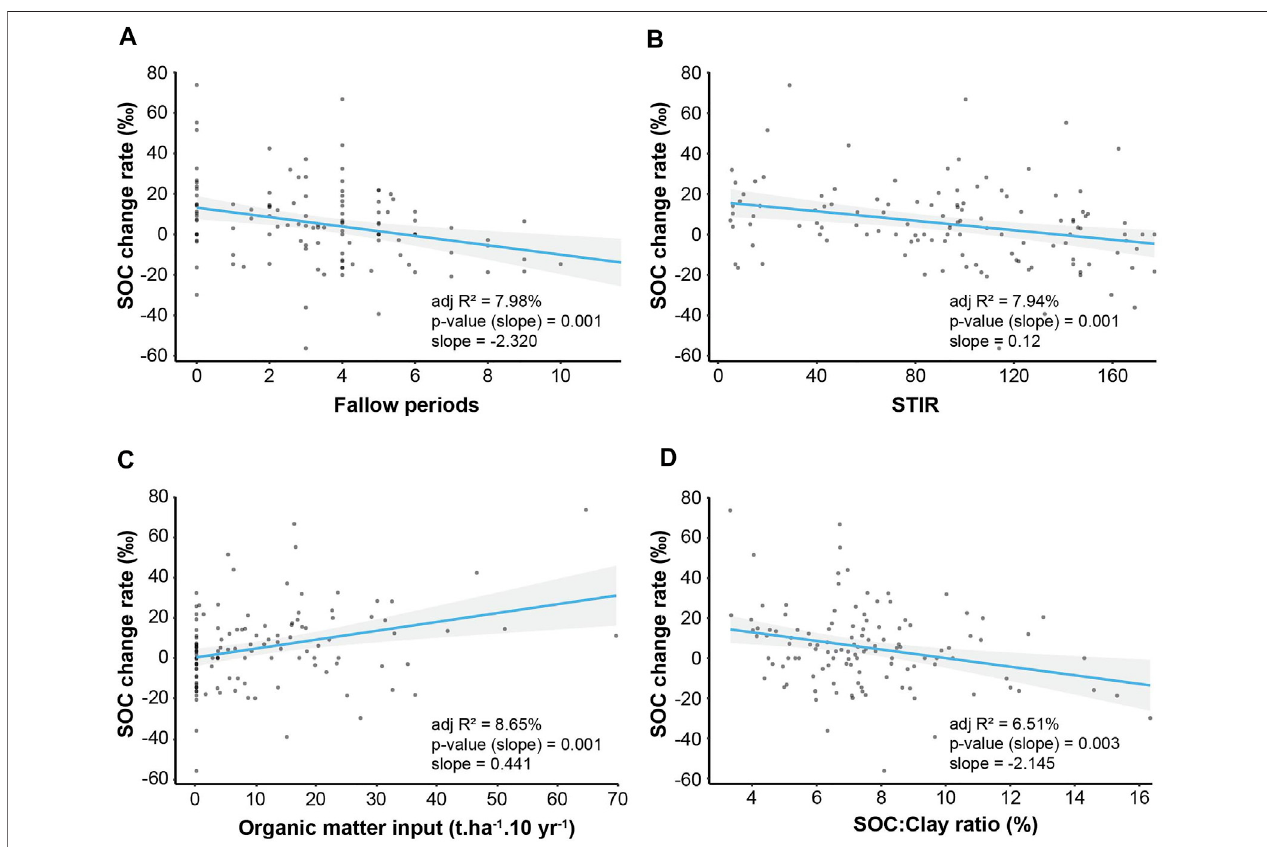
FIGURE3| Linear regressions betweenSOC annualchange rates( ‰ )and croppingpractices( (A) : fallowperiods, (B) : SoilTillageIntensity(STIR) and (C) :organic matter input) and between SOC annual change rates ( ‰ ) and initial SOC:Clay ratio (%) (D) .